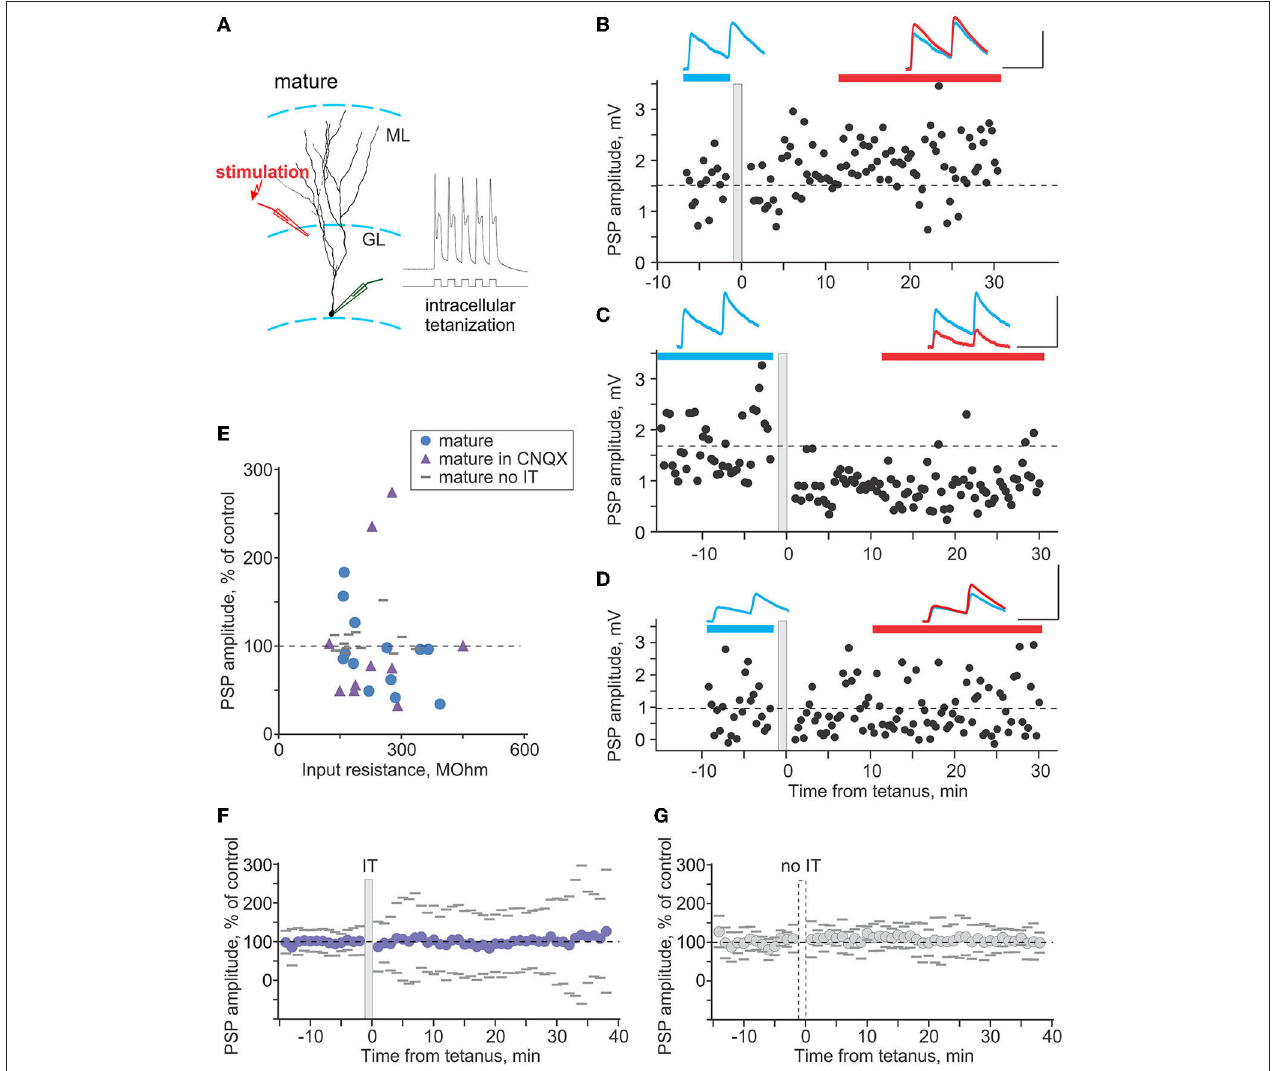
FIGURE 4 | Plasticity induced by intracellular tetanization in mature neurons. (A) A scheme of recording from a mature neuron and location of stimulation electrode, and response of the neuron to one burst of intracellular tetanization (5 brief depolarizing pulses at 100Hz). (B–D) Three example experiments in which intracellular tetanization induced LTP (B) , LTD (C) , or did not lead to changes of synaptic responses in mature neurons (D) . Each time course shows individual PSP amplitudes; dashed horizontal line shows mean PSP amplitude before intracellular tetanization (gray vertical bar). PSPs above the plots are averages over the periods indicated by the horizontal bars of respective color, before and after intracellular tetanization. Scale bars: 50ms, 2mV. (E) PSP amplitude in percentage of control after intracellular tetanization (or no tetanization), plotted against input resistance. Intracellular tetanization was applied in experiments without synaptic blockers ( n = 13 blue circle symbols), with 10 µ m CNQX in the recording medium ( n = 10, violet triangle symbols). In n = 12 experiments without synaptic blockers, no tetanization was applied (gray horizontal dash symbols). (F,G) Summary time course of PSP amplitude changes, in percentage of control, in experiments with intracellular tetanization [ (F) , n = 23 cells, “IT”] and without intracellular tetanization [ (G) , n = 12 cells, “no IT”]. For each cell, PSP amplitudes were normalized to control and then average responses over 1min periods were calculated. These 1-min averages were used to calculate average (circle symbols) and SD across cells. Gray dashes show ±